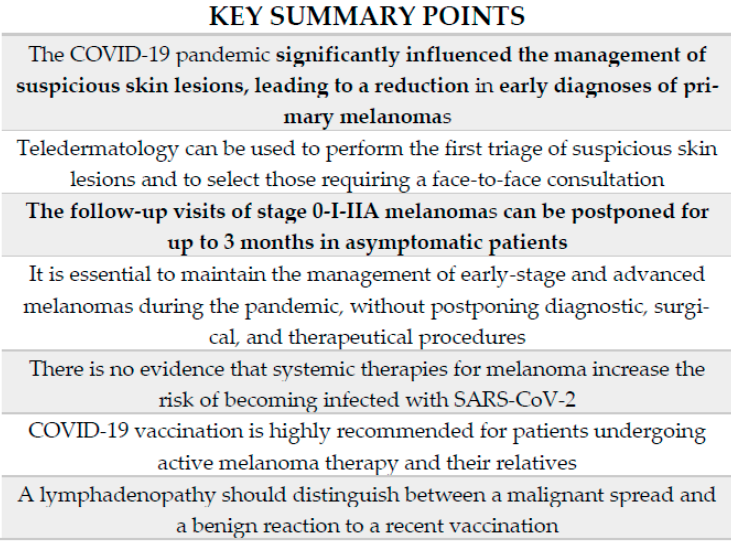
Figure 1. The main topics discussed in the literature